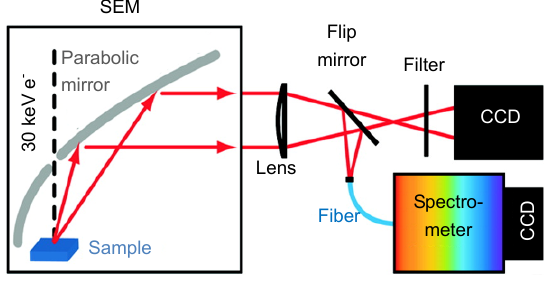
Fig. 1 | Schematic overview of a CL imaging spectrometer with spectral analysis function . Figure reproduced from ref. 11 , CUP